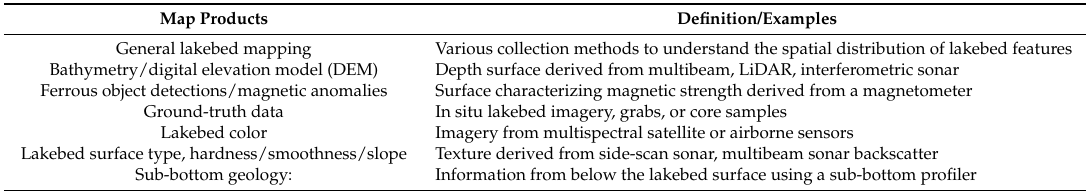
Table 1. Map Products listed in the pull-down menus to convey what types of lakebed maps are needed. Map